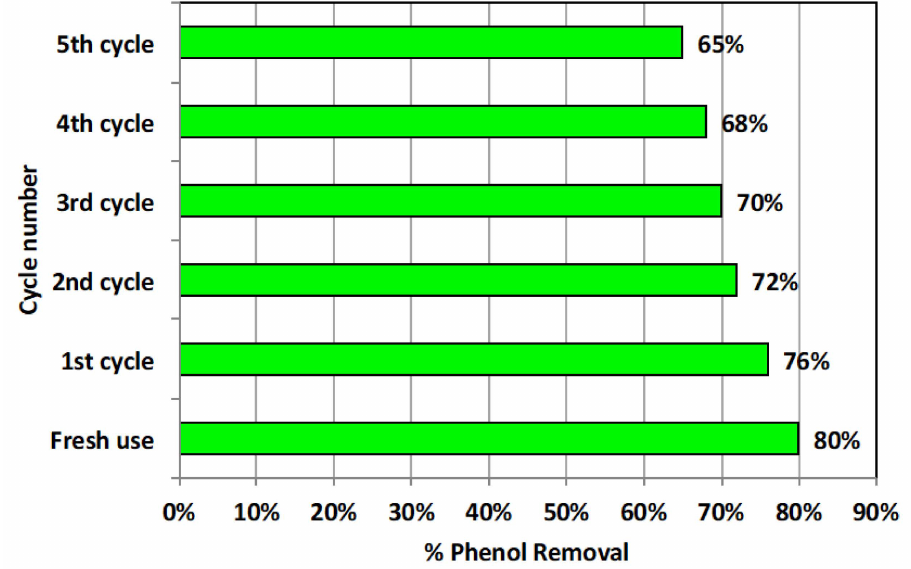
Figure 10. Adsorbent cyclic use activity in phenol